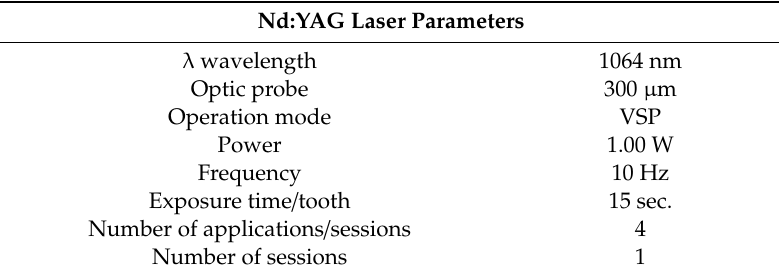
Table 1. Nd:YAG (neodymium-doped yttrium aluminum garnet; Nd: Y 3 Al 5 O 12 ) laser parameters for therapeutic intervention in the study.